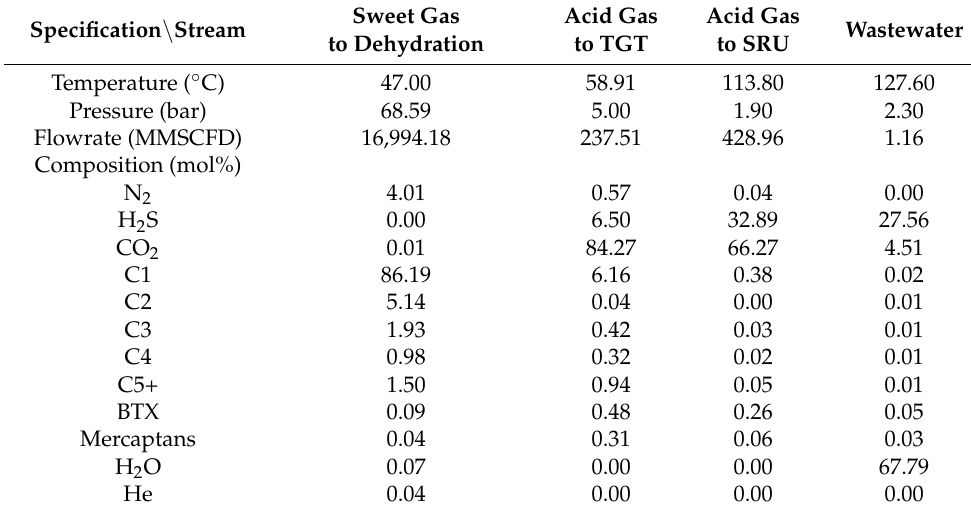
Table 4. Sweeting unit conditions and specifications.